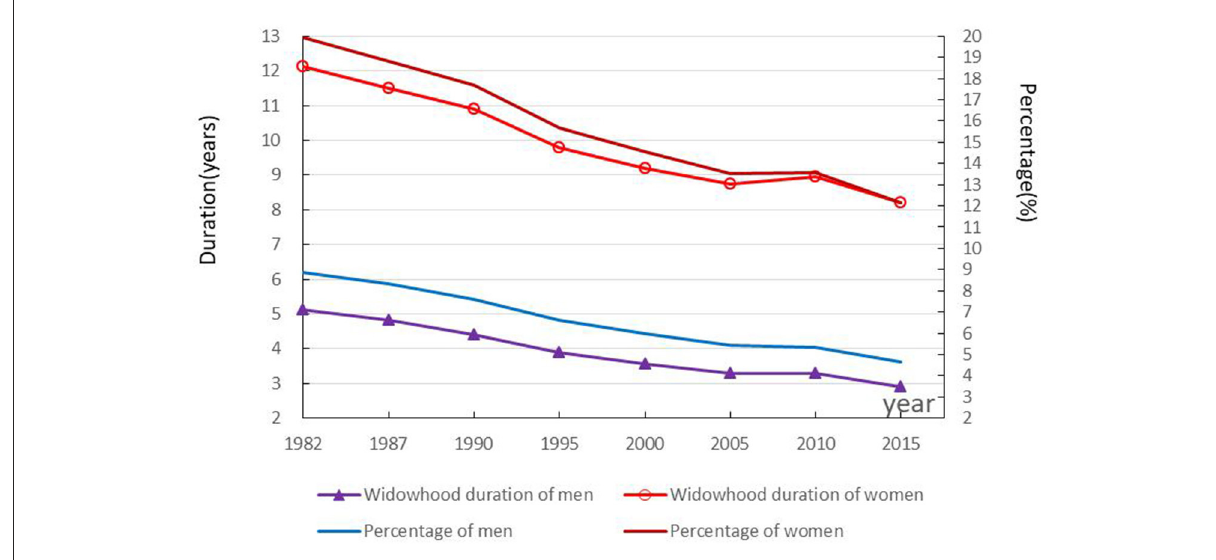
FIGURE4 Trends in widowhood duration and proportion among